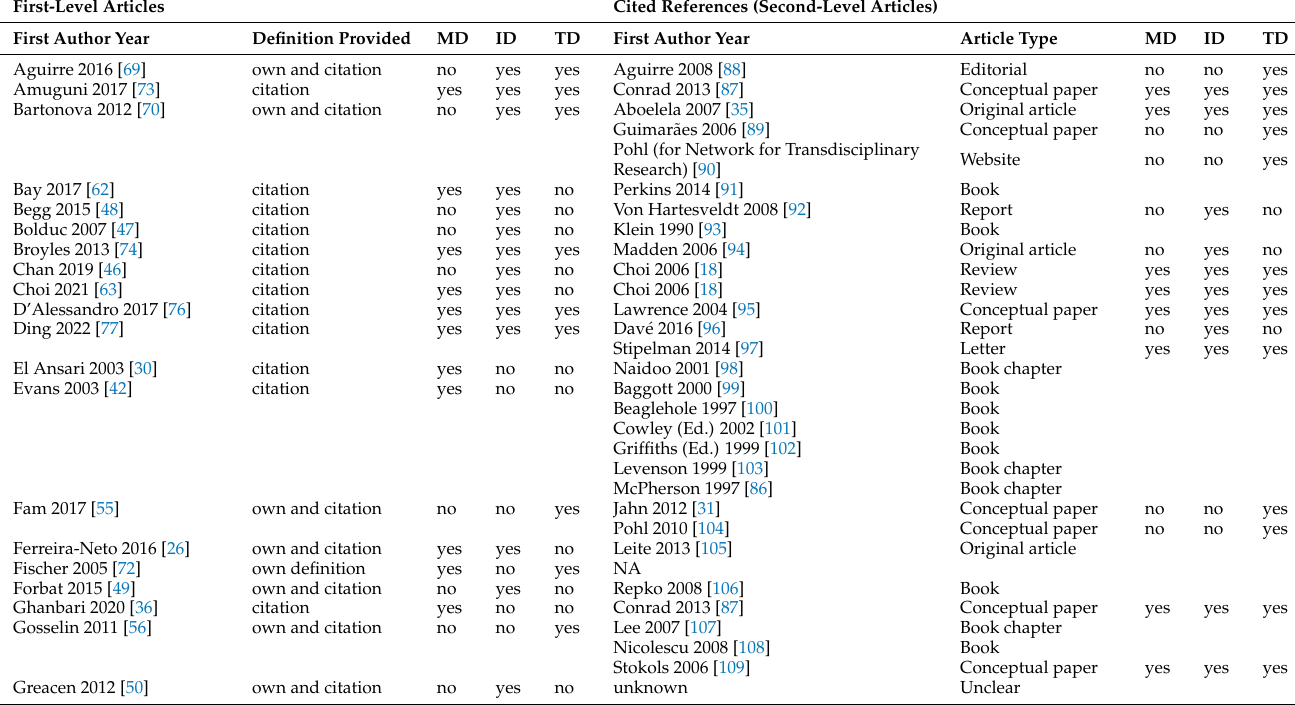
Table 2. Overview of first-level articles with definitions and linked second-level